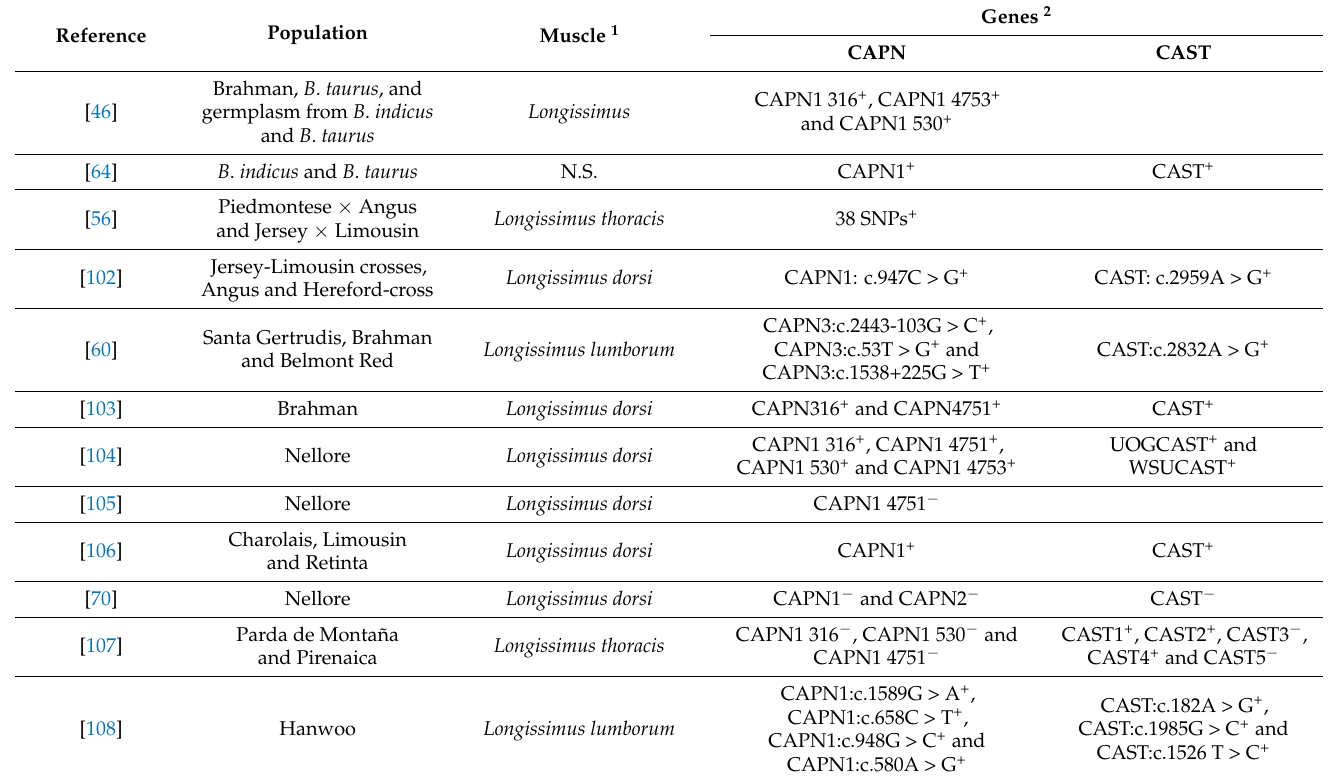
Table 7. Studies on the role of CAPN and CAST genes and their SNPs on meat tenderness (measured by shear force tests) in